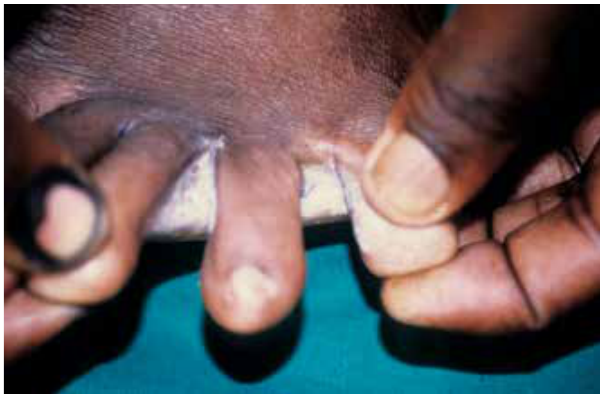
Figure 6: Tinea pedis, with maceration in the web spaces